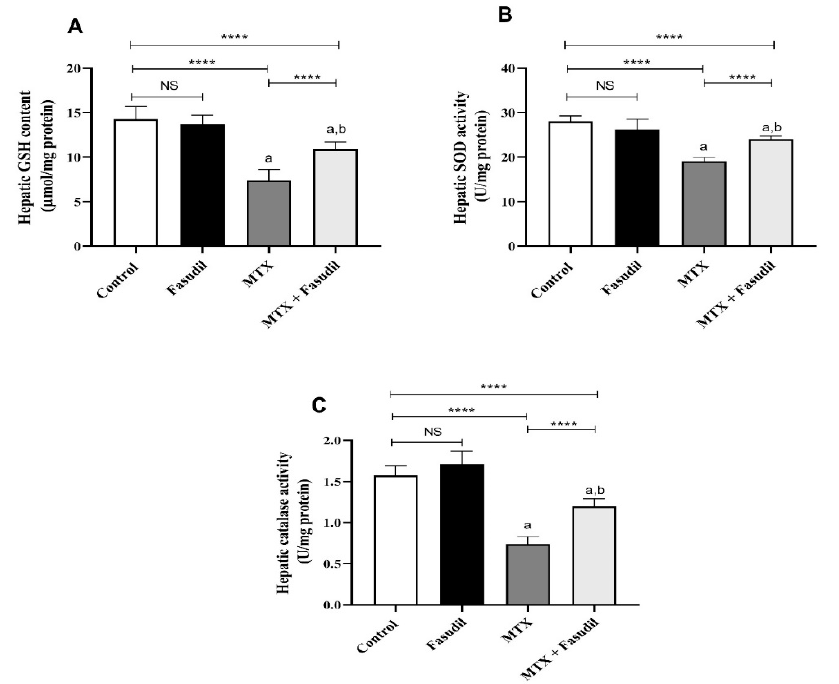
Figure 4. Effect of fasudil on the hepatic GSH content as well as antioxidant enzyme activity: ( A ) hepatic GSH content; ( B ) hepatic SOD activity; ( C ) hepatic catalase activity. Results are presented as mean ± SEM ( n = 8); a: significant difference from the control group ( p < 0.05); b: significant difference from the MTX group ( p < 0.05). **** p < 0.0001. NS, non-significant.